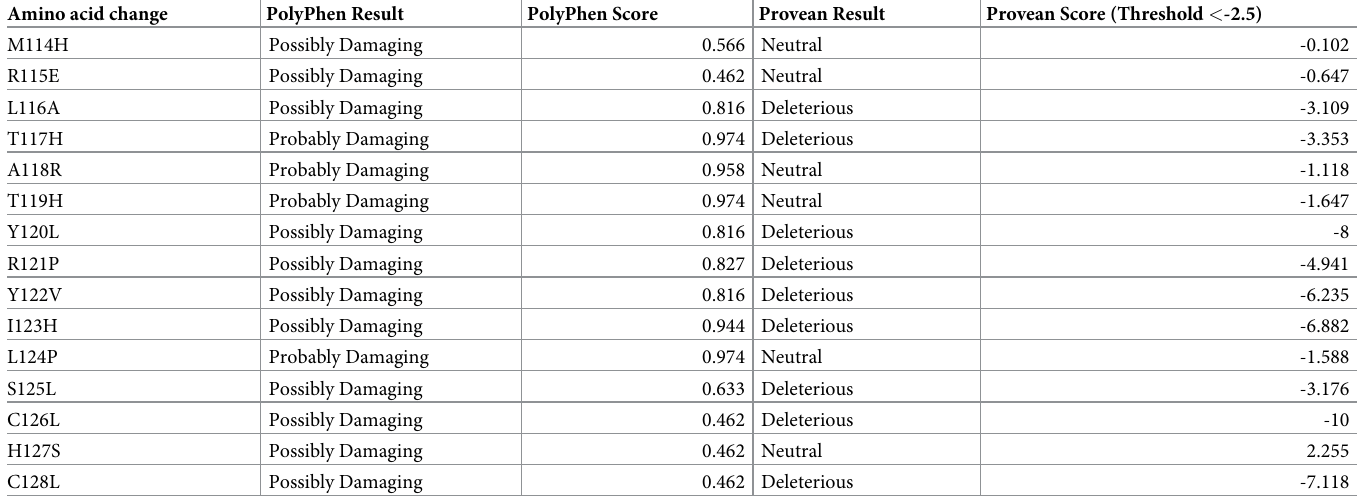
Table 1. Predicted